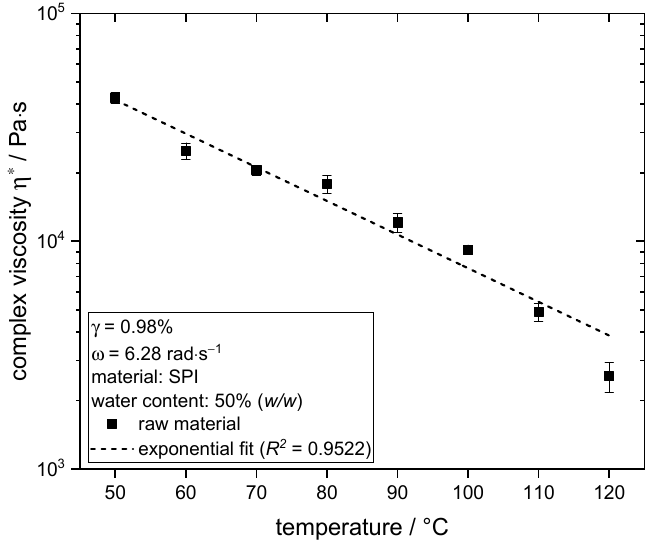
Figure 6. Complex viscosity of raw material SPI at 50% ( w/w ) water content as a function of temperature, determined at constant γ = 0.98% and ω = 6.28 rad·s − 1 .